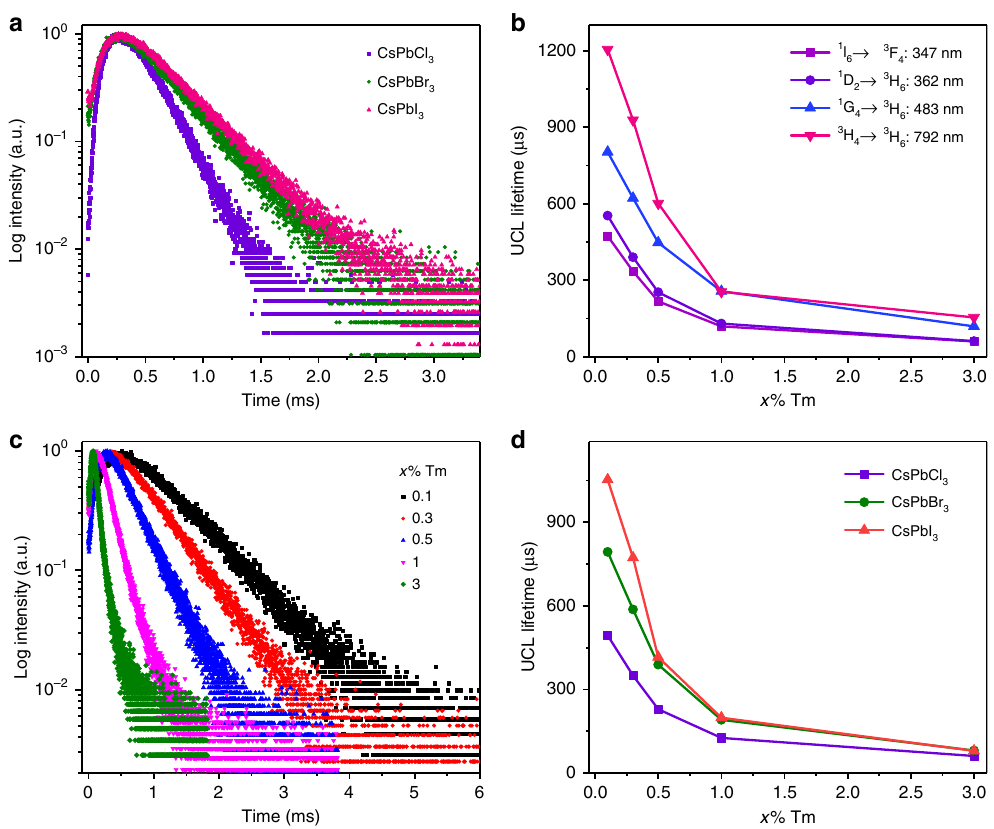
Fig. 5 Upconversion lifetime tuning in nanoparticle (NP)-sensitized CsPbX 3 perovskite quantum dots (PeQDs). a Upconversion luminescence (UCL) decays from the upconverted excitons in NP-sensitized CsPbCl 3 , CsPbBr 3 , and CsPbI 3 PeQDs (0.5 mol% Tm 3 + ) by monitoring their emissions at 410, 520, and 700 nm, respectively, under 980 nm excitation. b UCL lifetimes of 1 I 6 , 1 D 2 , 1 G 4 , and 3 H 4 of Tm 3 + in LiYbF 4 :x%Tm 3 + @LiYF 4 core/shell NPs as a function of the Tm 3 + concentration. c UCL decays from the upconverted excitons in NP-sensitized CsPbBr 3 PeQDs with varying Tm 3 + concentration in the NPs. d UCL lifetimes of CsPbCl 3 , CsPbBr 3 , and CsPbI 3 PeQDs as a function of the Tm 3 +